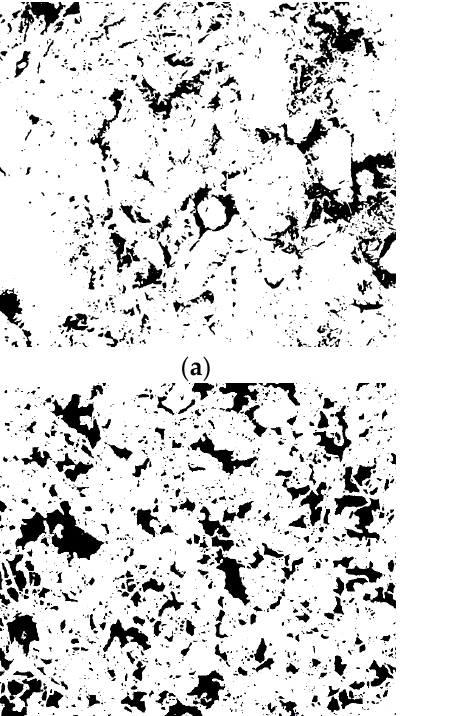
Figure 6. Proportion of pores and cracks in SEM morphology. 4. Engineering Application To illustrate the application of the proposed model to pavement maintenance, a typ- ical highway section was adopted for a case study. The highway section was asphalt con- crete pavement with a design life of 15 years. The pavement structures from top to bottom included 4 cm medium-grain asphalt concrete, 5 cm coarse-grain asphalt concrete, 7 cm hot mix asphalt crushed stone, 20 cm cement-stabilized crushed stone base and 35 cm lime-stabilized soil. Since the completion of the pavement, the traffic volume has been heavy, and the proportion of overloaded and heavy vehicles has been relatively high. Therefore, under long-term traffic load, serious network cracks appeared on the road sur- face (Figure 7). After water flowed through the cracks to the base, the hydrodynamic pres- sure soon softened the fine soil and undermined its strength under traffic load. Thus, this